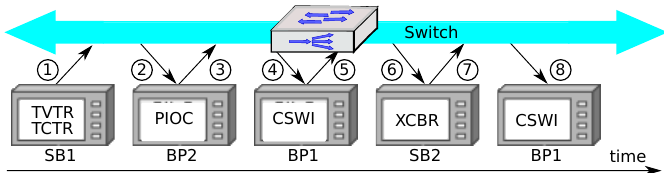
Figure 4. Intrabay sequence of events among protection and control